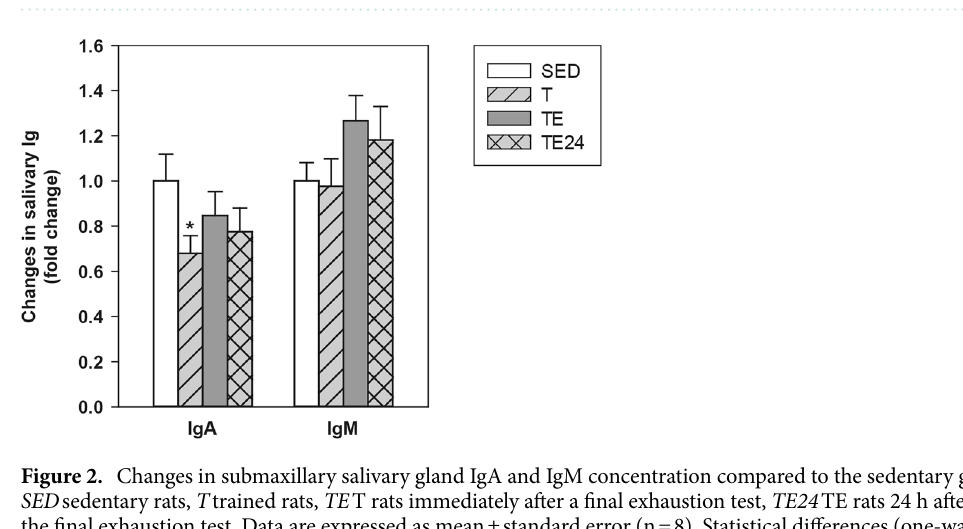
Figure 1. Body weight ( a ), chow intake ( b ), and food efficiency ( c ) throughout the intensive training period. The sedentary (SED) group is represented by white symbols ( ○ ) and the runner group by grey symbols ( ). Data are expressed as mean ± standard error (n = 8 animals for the SED group and n = 24 animals for the runner group in ( a ); n = 3 cages for the SED group and n = 8 cages for the runner group in b , c ). Statistical differences (Student’s t test): *p < 0.05 vs SED group.